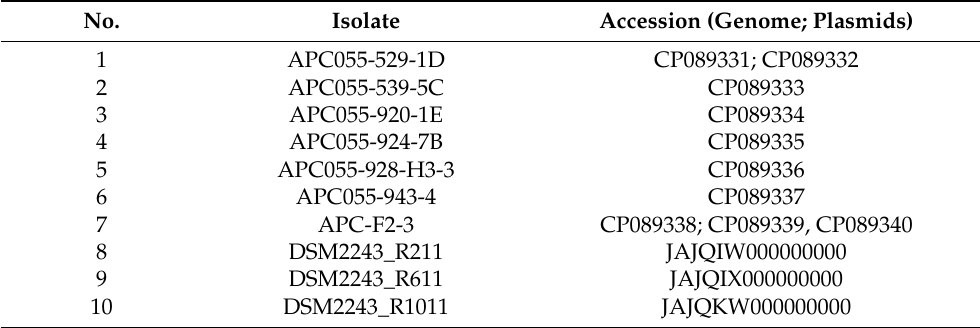
Table 1. Accession numbers (DDBJ/ENA/GenBank) for genomes/plasmids of E. lenta isolated in this